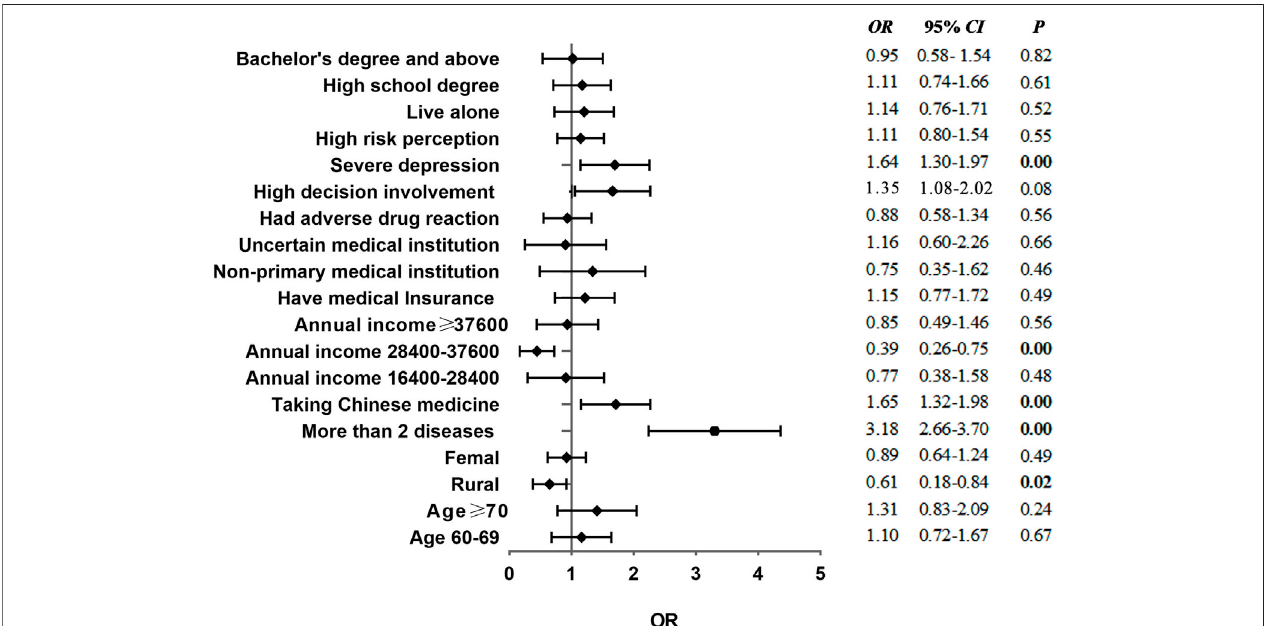
FIGURE 1 | Forest plot of logistic regression analysis results of polypharmacy before matching.